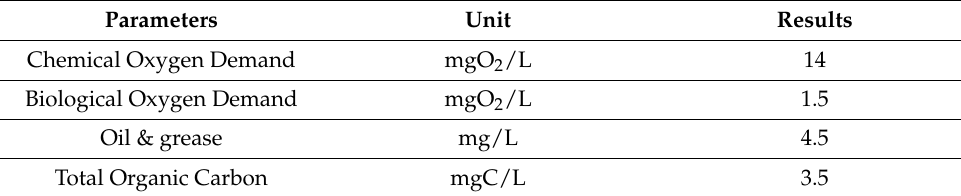
Table 6. Organic analysis of seawater.